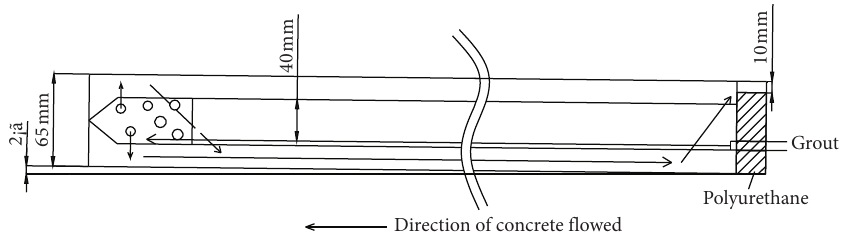
Figure 9: Schematic diagram of concrete pouring section.